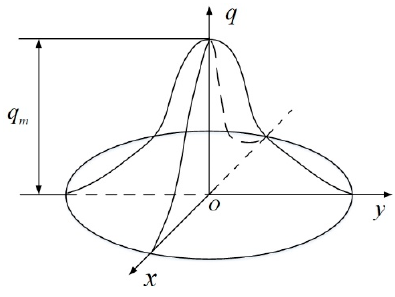
Figure 4. Gaussian heat source model.